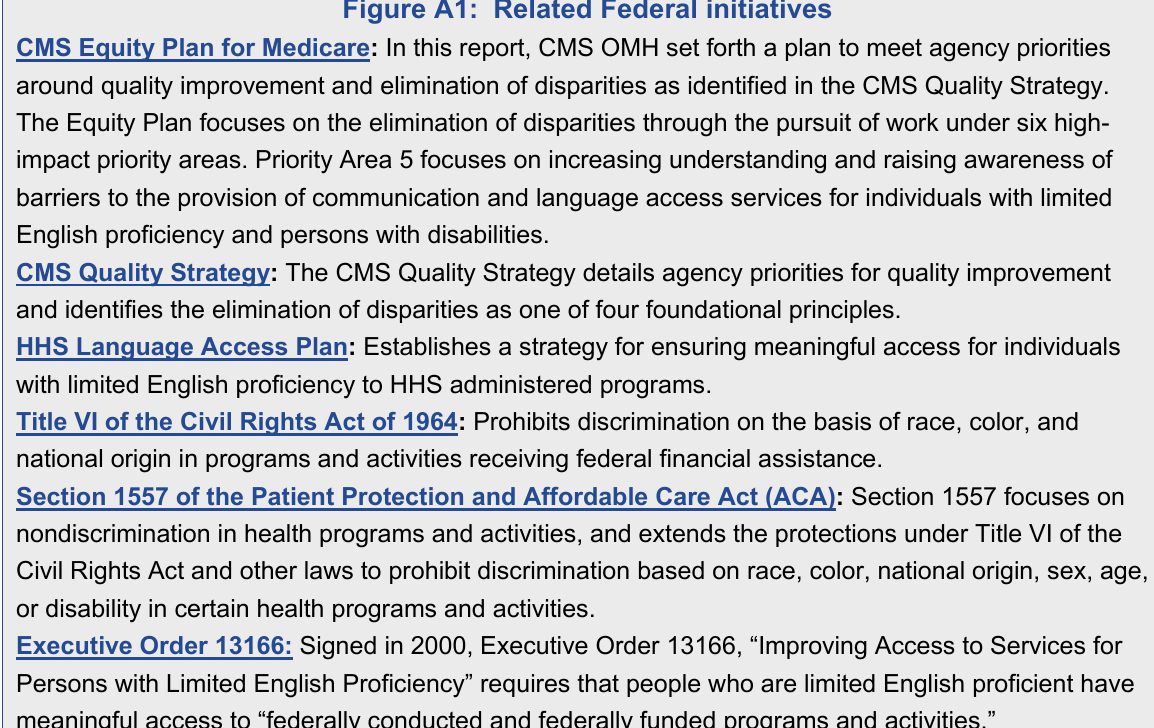
Figure A1: Related Federal